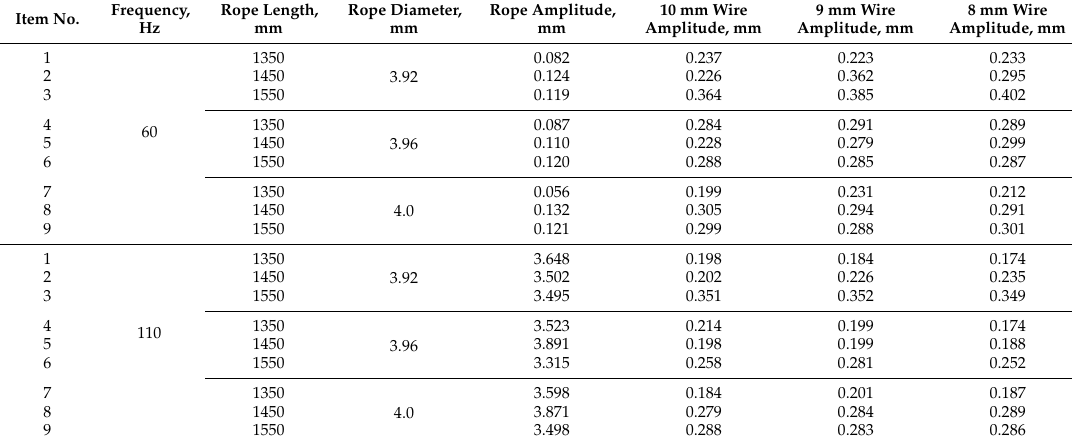
Table 1. Structure of rope vibration experimental